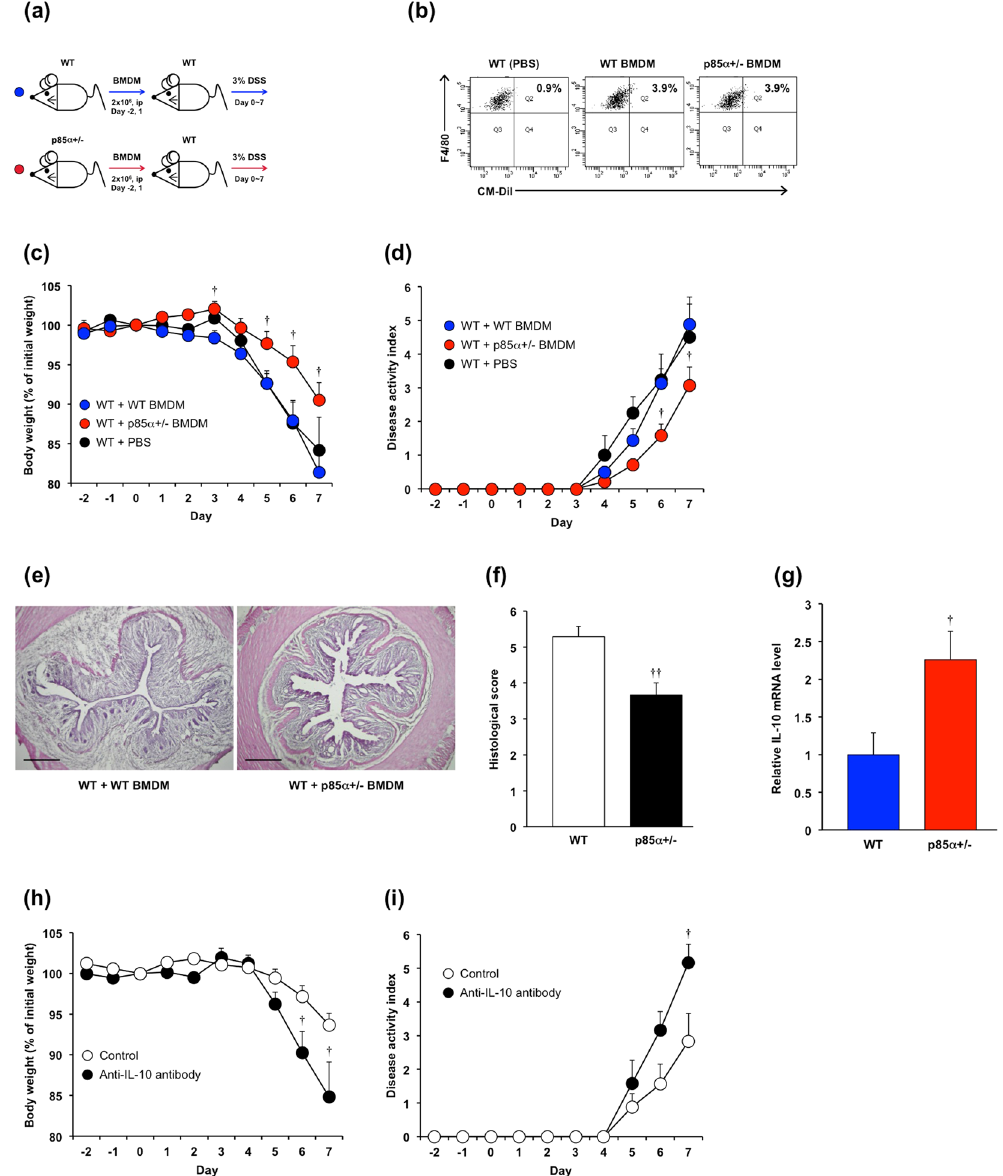
Figure 6. High IL-10-producing macrophages suppress the development of DSS-induced acute colitis in WT mice. ( a ) Schematic drawing of the experimental design for the evaluation of BMDM adoptive transfer in the DSS-induced acute colitis model. BMDMs from WT or p85 α+ / − mice were intraperitoneally injected into WT mice at 2 days before and 1 day after the start of DSS treatment. ( b ) Representative flow cytometry plots show the proportion of CD11b + F4/80 + CM-DiI + intestinal macrophages in cLP cells. Plots were representative of the results from 3 independent experiments. Body weight ( c ), disease activity index ( d ) and representative images of H&E staining ( e ) are shown. Scale bar is 300 μ m. ( f ) Histological scoring of DSS-induced colitis. ( g ) IL-10 mRNA expression in the mouse colons of WT BMDM or p85 α+ / − BMDM-transferred colitis mice. The data are presented as the mean ± SE of 4 mice and are representative of 1 out of 3 independent experiments. † p < 0.05; †† p < 0.01, compared with WT BMDM. ( h , i ) Effect of anti-IL-10 antibody on the ameliorative action of p85 α+ / − BMDM against the development of DSS-induced colitis in WT mice. Anti-IL-10 antibody or control IgG was injected intraperitoneally into p85 α+ / − BMDM-transferred WT mice 2 h before the start of DSS treatment and then every other day. Body weight ( h ) and disease activity index ( i ) are shown. The data are presented as the mean ± SE of 5 mice and are representative of 1 out of 2 independent experiments. † p < 0.05, compared with